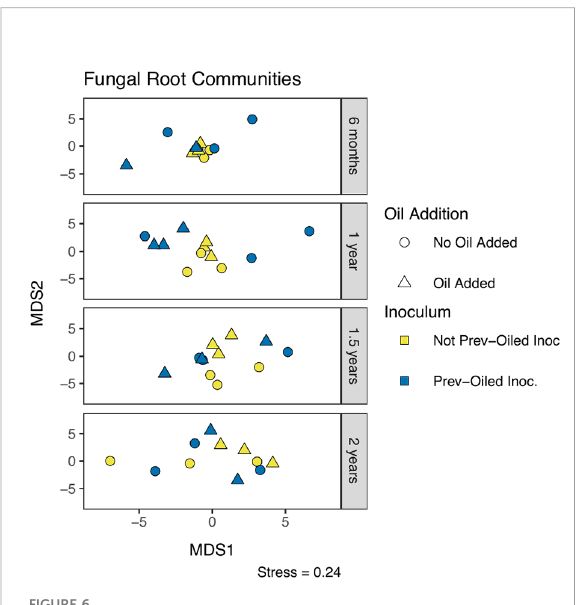
FIGURE 5 NMDS of fungal community composition in soil, measured by Aitchison distance. Each point represents a single replicate at a time point. Sampling points correspond to individual panels, chronologically from top to bottom. The two columns of panels represent whether or not a plant was in the mesocosm. The oil addition treatment is represented by shape and the inoculum treatment by color.